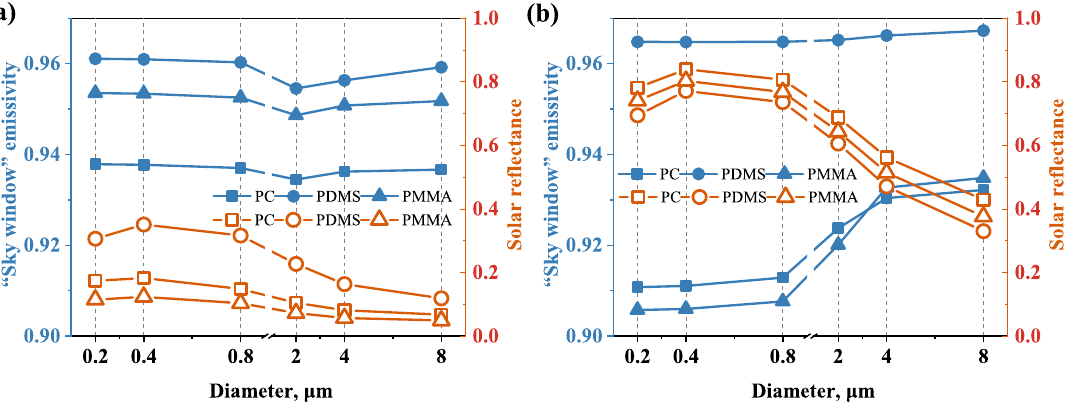
Figure 2. Effect of diameter on the radiative properties of RDSP structure ( a ) and porous structure ( b